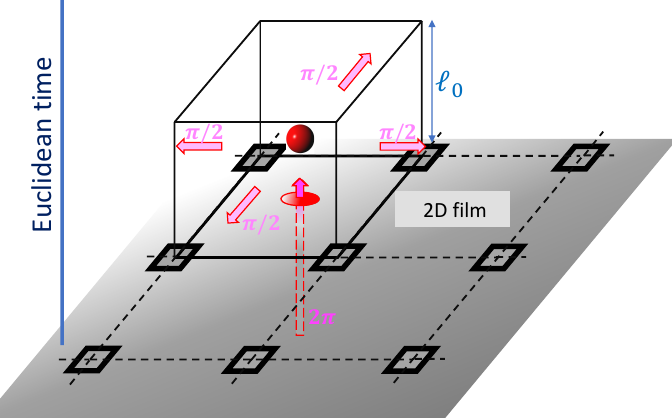
Figure 4. A non-relativistic magnetic monopole instanton representing a quantum tunnelling event in which a fundamental vortex of flux 2 π at time t is divided up into four fluxes π /2 that flow out isotropically in the spatial directions. At the next instant t + (cid:96) 0 there is no vortex on the film anymore. For simplicity the condensate islands are represented schematically as in a regular